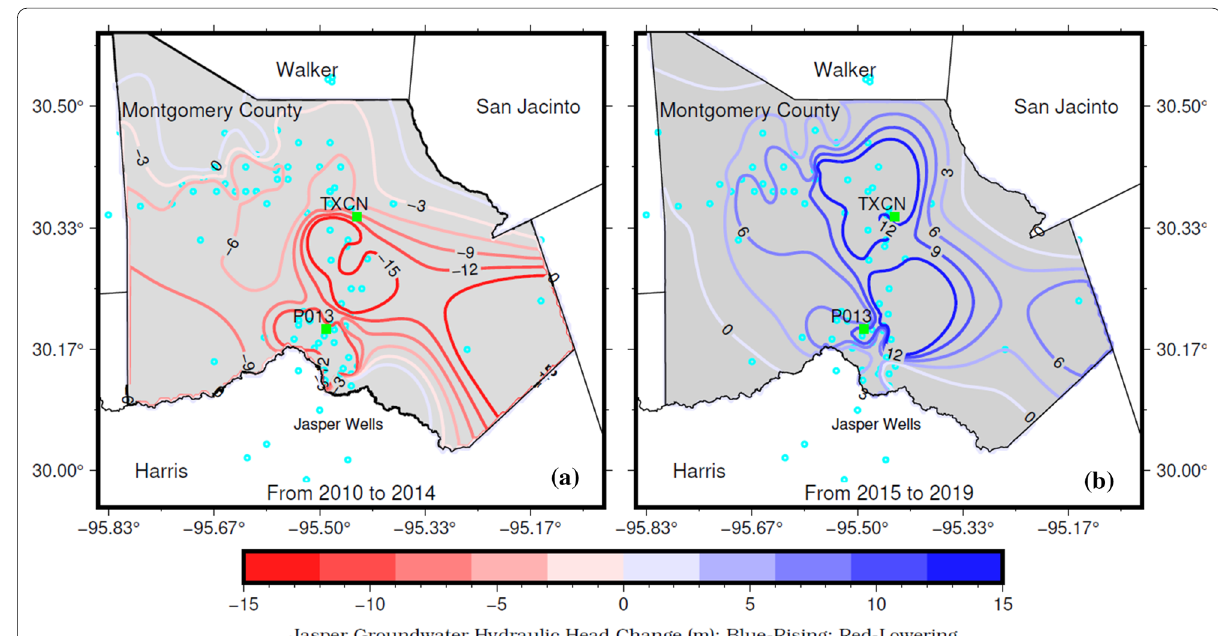
Fig. 4 Jasper groundwater-level changes in Montgomery County. a The change of groundwater altitude during the 5-year period from the beginning of 2010 to the end of 2014; b the change of groundwater altitude in meters during the 5-year period from the beginning of 2015 to the end of 2019. The color bar indicates the magnitude of groundwater altitude changes in